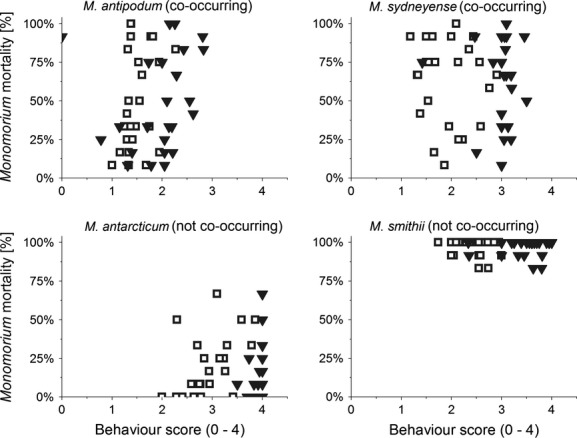
Monomorium mortality in arena fights. Mortality of Monomorium workers in arena fights against Argentine ants depending on average individual aggression within the same replicate (open squares) and average maximum aggression within the same replicate (closed triangles). Behavior scores were taken as follows: 0 = no interest or aggression; 1 = interest shown via antennation; 2 = ant retreats quickly; 3 = lunging, biting or leg pulling, raising of gaster, and exuding venom; and 4 = prolonged (>5 sec) incidences of aggression, individuals locked together, and fighting.